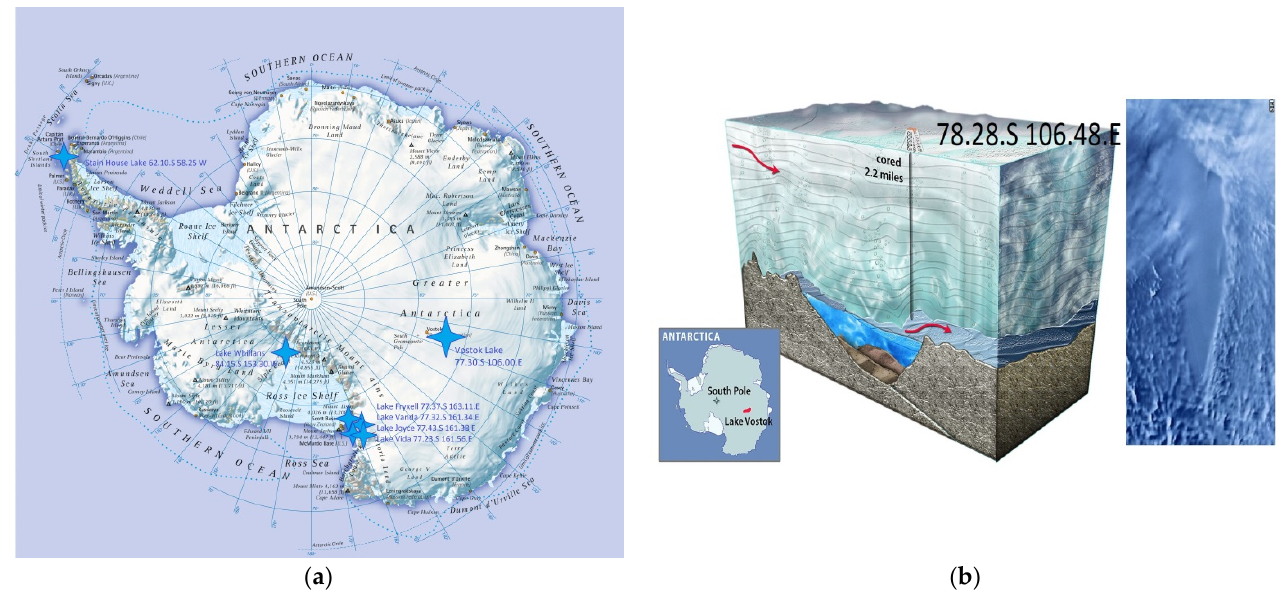
Figure 1. Location of the most studied lakes in Antarctica ( a ) and 5G borehole in Lake Vostok ( b ).